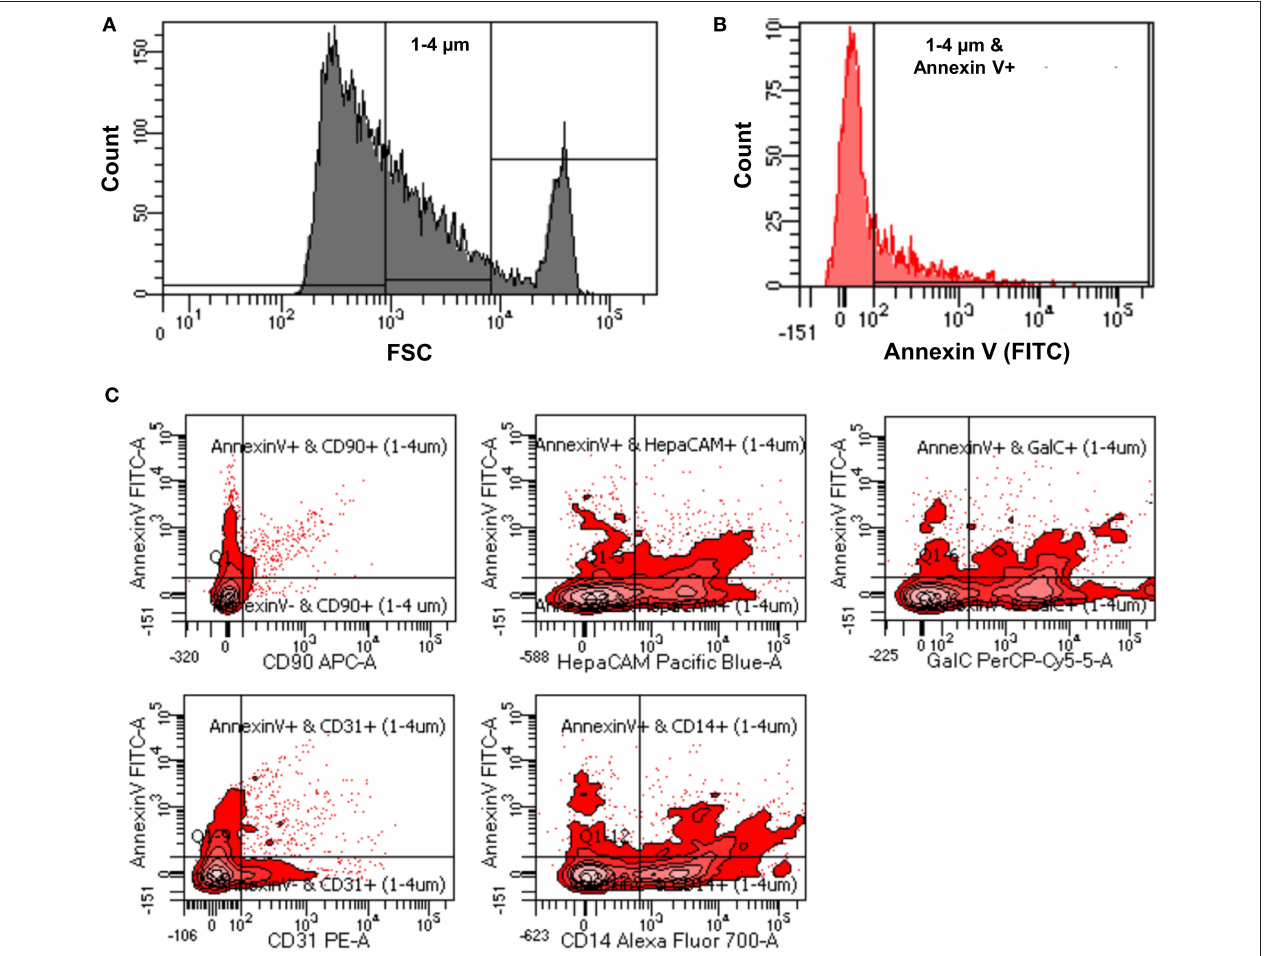
FIGURE 3 | (A) Representative flow cytometry image indicating how size gate was used to select 1-4 µ m vesicles from patients’ CSF samples. (B) Representative flow cytometry image showing process of identification of ABs from 1 to 4 µ m sized vesicles using Annexin V-FITC staining (1–4 µ m and Annexin V-positive events). (C) Representative flow cytometry images showing how origin of ABs was identified using CNS cell-specific surface markers staining.